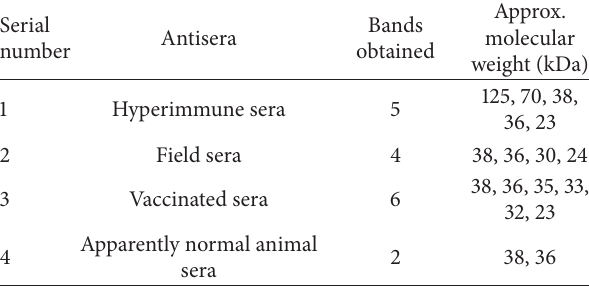
Table 2: The immunodominant bands obtained in western blot analysis by using different type of antiserum against outer mem- brane proteins of Pasteurella multocida